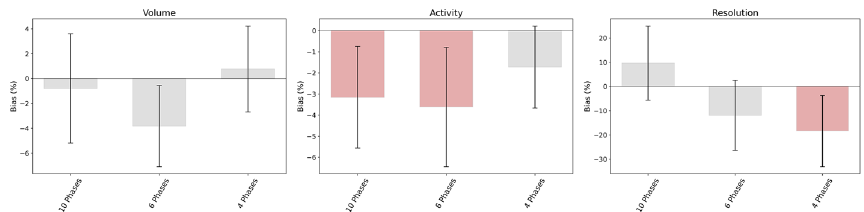
Fig. 16 Bland–Altman and WSRT results for the comparison of 8 Phases with respect to retrospective protocols. The columns represent the average value for the relative deviation in percentage between paired series of data. The error bars represent the interval of confidence. When the interval involves the zero, series are considered comparable. The protocols not comparable under WSRT are shown in